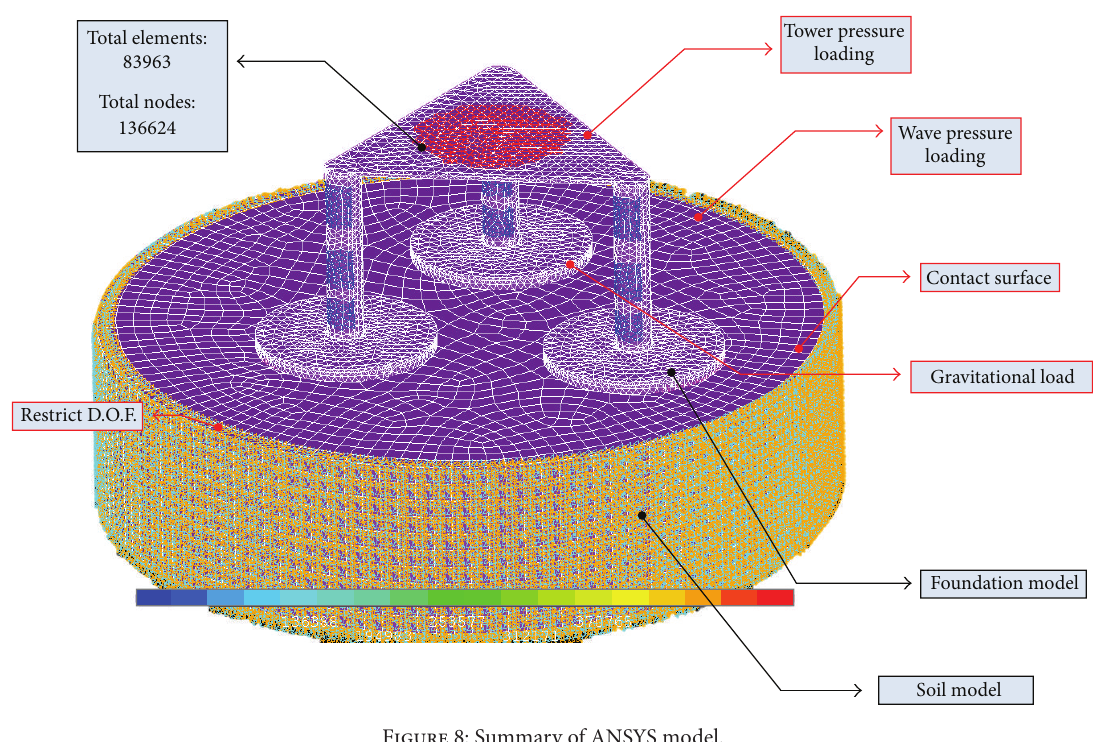
Figure 8: Summary of ANSYS